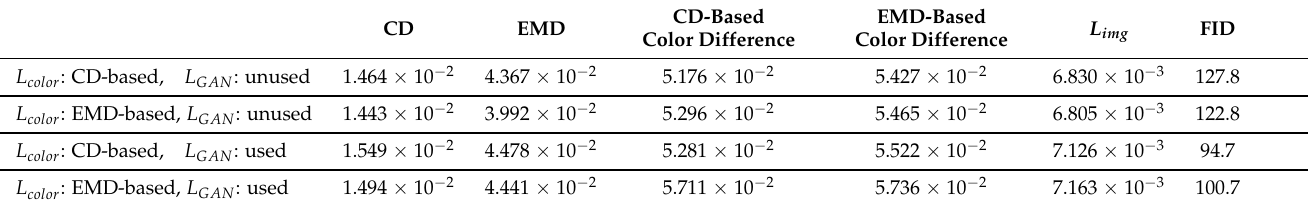
Table 1. Evaluation results of learning with MSN.